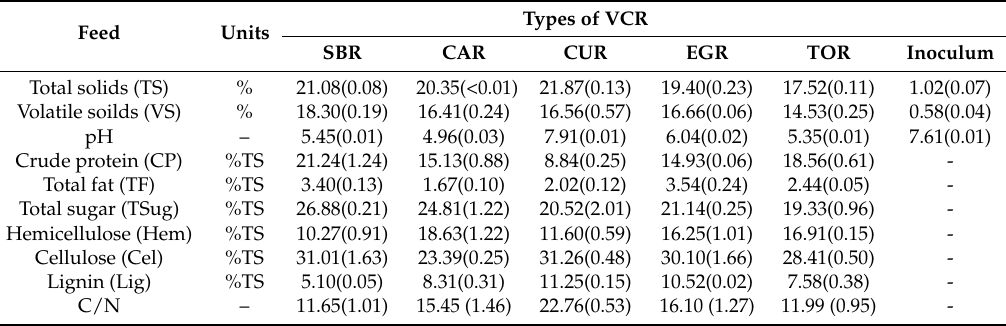
Table 1. Characteristics of five different VCRs and